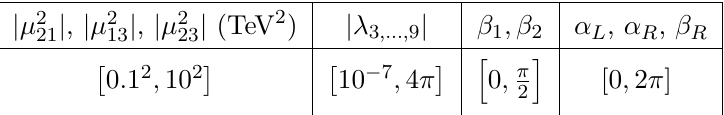
Table 2 . Ranges used for the input parameters in our numerical scan. The values of the quark masses, of the CKM mixing elements and of the Higgs boson mass were fixed to their central values according to